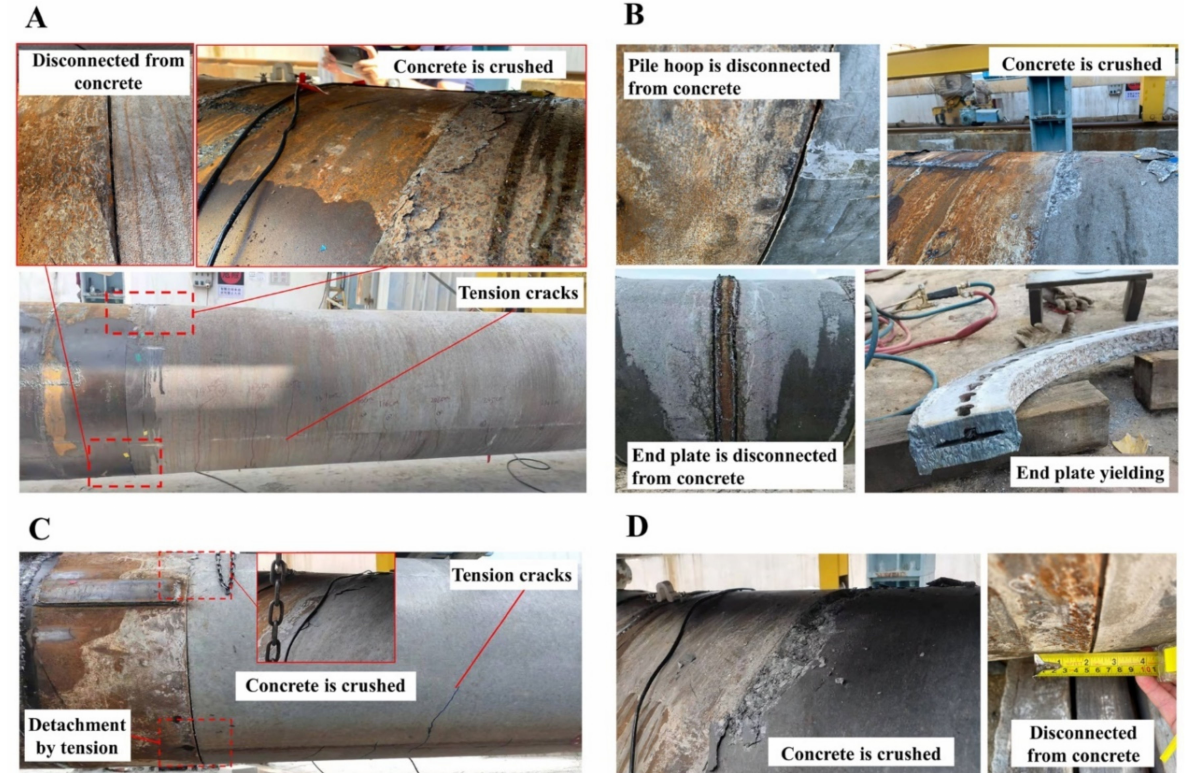
Figure 6. Failure modes of pipe pile joints: ( A ) JT1; ( B ) JT2; ( C ) JT3; ( D ) JT4. The strain measurement points were arranged at the bottom, middle, and top near the joint (see Figure 3) to obtain the strain variation characteristics of the joint under different loads, as shown in Figure 7, where positive strain values indicate tension and negative values indicate compression. Before the cracking load, the strain of the pile concrete attached to the joint developed slowly, and the load and strain were roughly linear, and the cracking load became an obvious inflection point, after which the strain change accelerated; in addition, the strain at the top and bottom of the weld was basically linear and significantly smaller than the strain of the pile concrete, and the weld was not damaged considering the practical